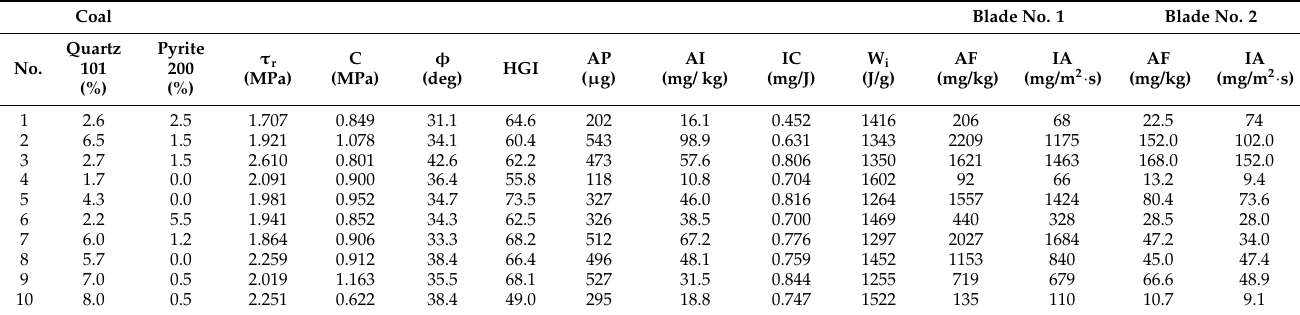
Table 2. Basic mechanical properties of ten bituminous coals, where bar No. 1 is made of carbon steel (0.08% C—standard steel) and bar No. 2 is made of cast iron (2.7% C, 22% Cr and 2% Mo). Coal Blade No.